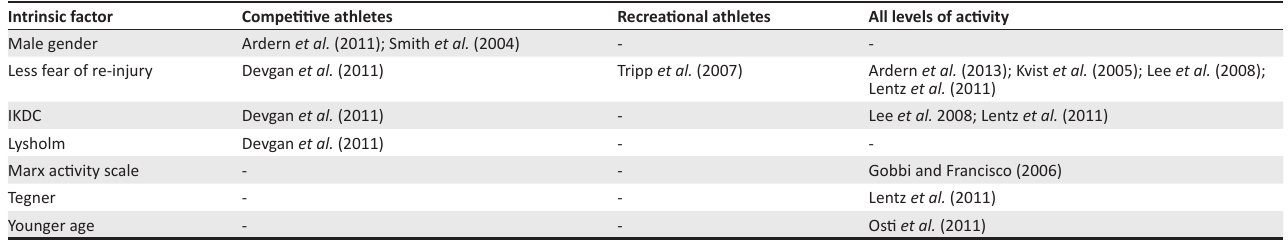
TABLE 6: Subgroup analysis of studies that investigated activity level and factors showing strong association with return to sport. Intrinsic factor Competitive athletes Recreational athletes All levels of